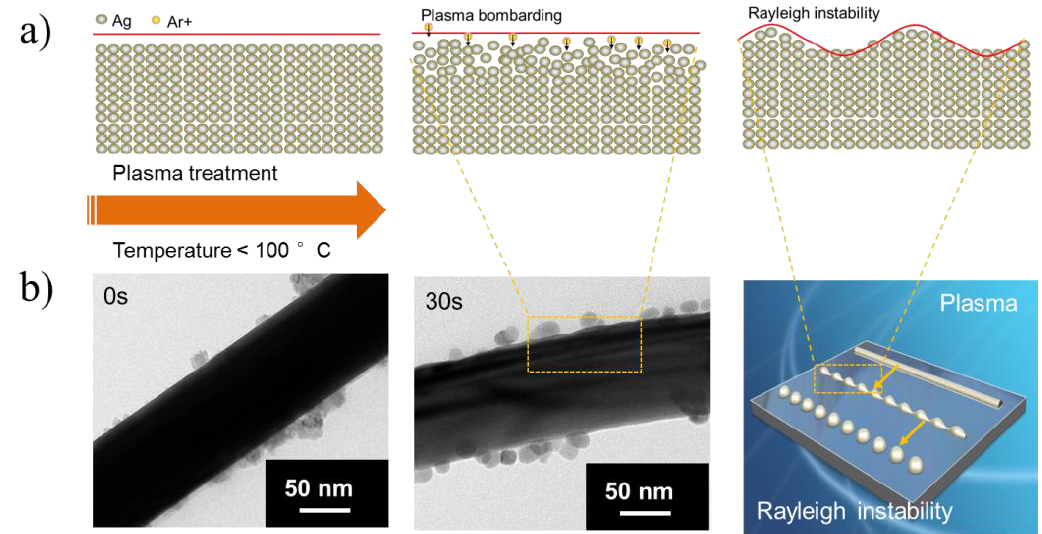
Figure 3. ( a ), Schematic illustration of the AgNWs during the plasma treatment. ( b ), TEM results of the evolution of AgNWs after 30 s and the possible evolution process of AgNWs to AgPCs. RF plasma power is 60 W.